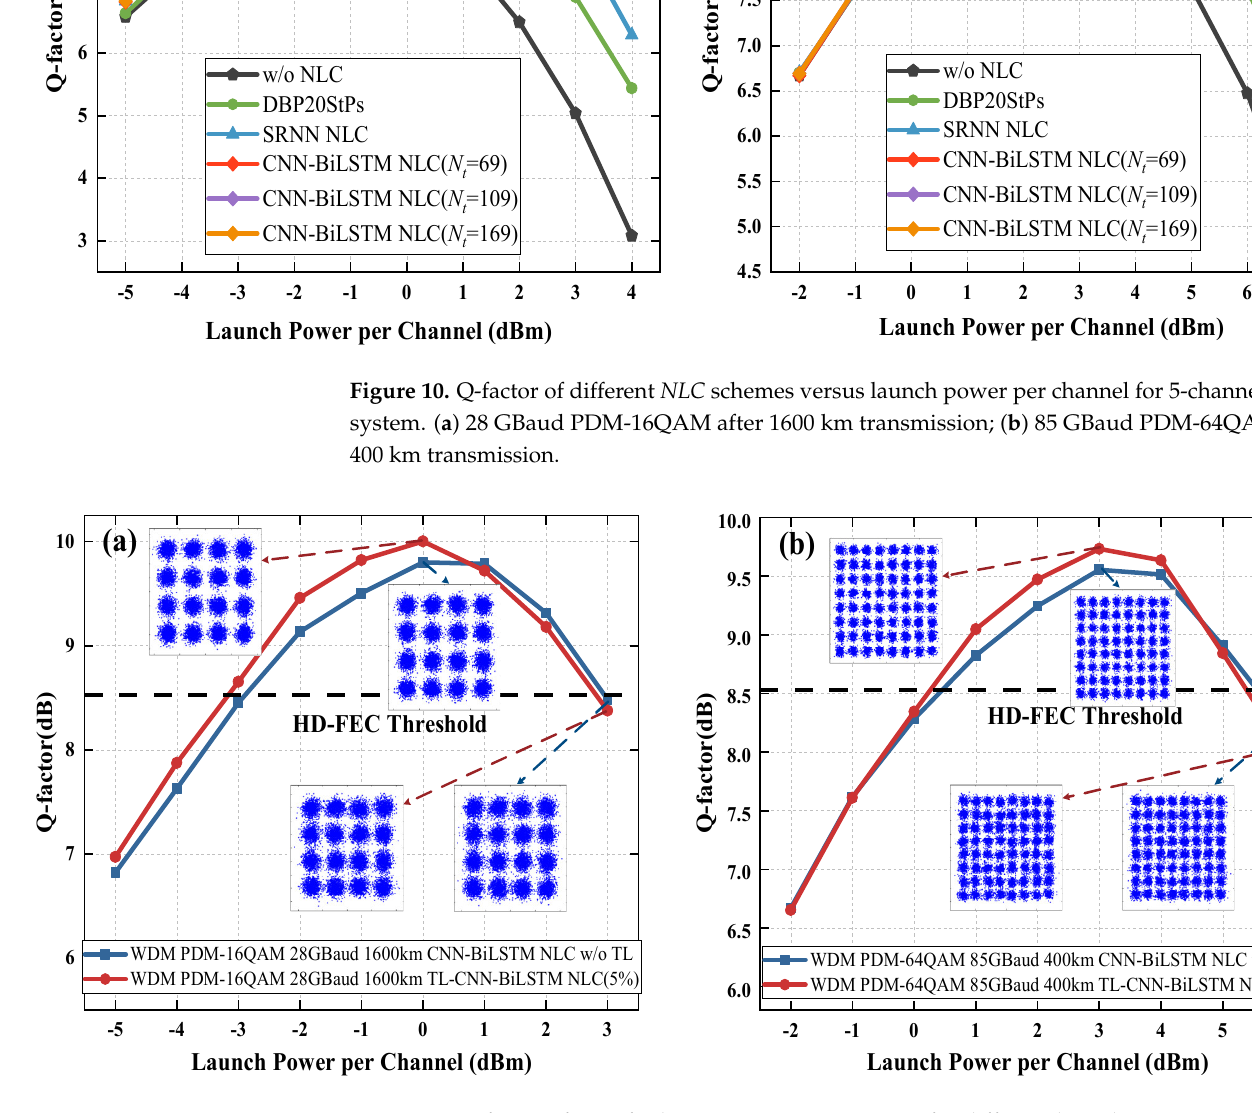
Figure 11. Q-factor of transfer learning versus retraining for different launch powers per channel. ( a ) 28 GBaud PDM-16QAM WDM after 1600 km transmission; ( b ) 85 GBaud PDM-64QAM WDM after 400 km transmission. Table 2. Comparison results of specific complexity of different schemes in simulation system.